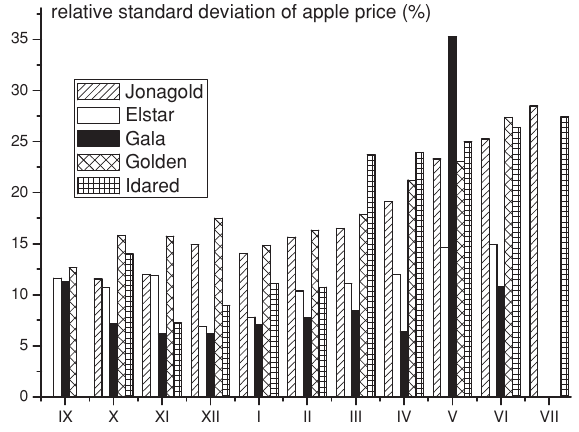
Figure 7. The relative standard deviations of apple price in Germany during the seasons